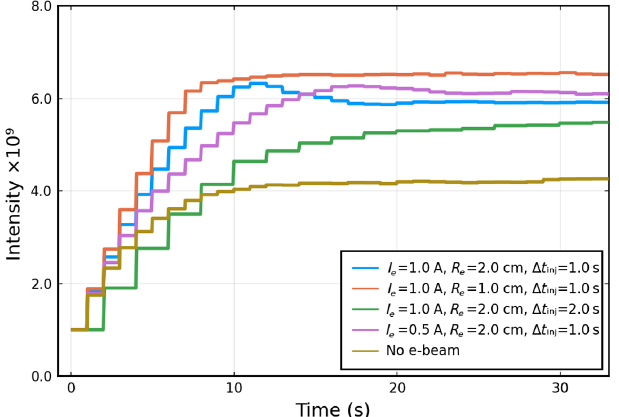
8. Comparison of the stacking process with different settings in